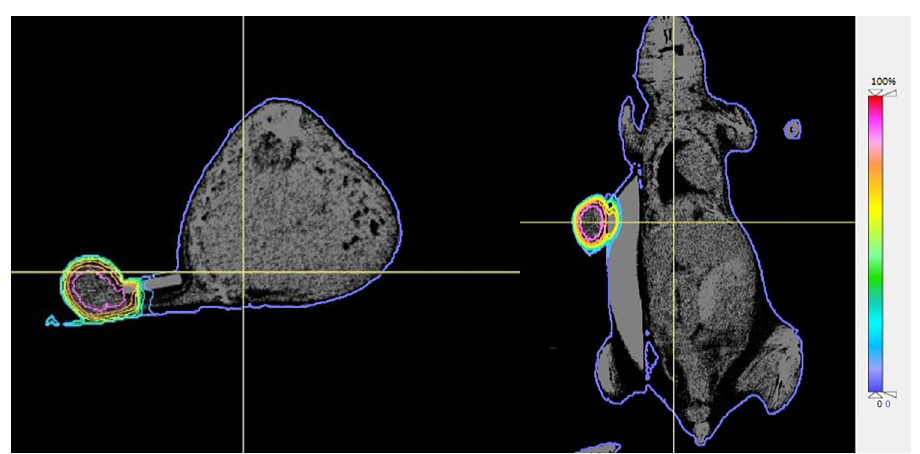
Fig 7. Isodose demonstration on micro-CT images in CERR. The sagittal (left) and coronal (right) isodose lines are demonstrated. Doses are normalized to the D max . Isodose lines within the tumour show an increase in dose level from the edge to the centre of the tumour. The purple isodose encircling the mouse body indicates the constant dose level of 7% of D max to the mouse body.